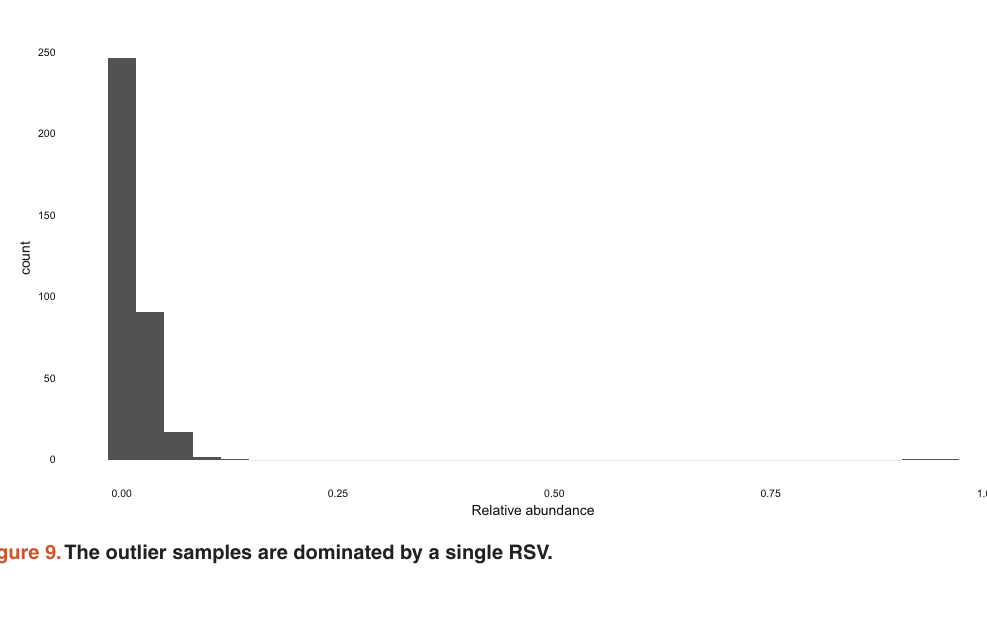
Figure 8. An ordination on the logged abundance data reveals a few outliers.